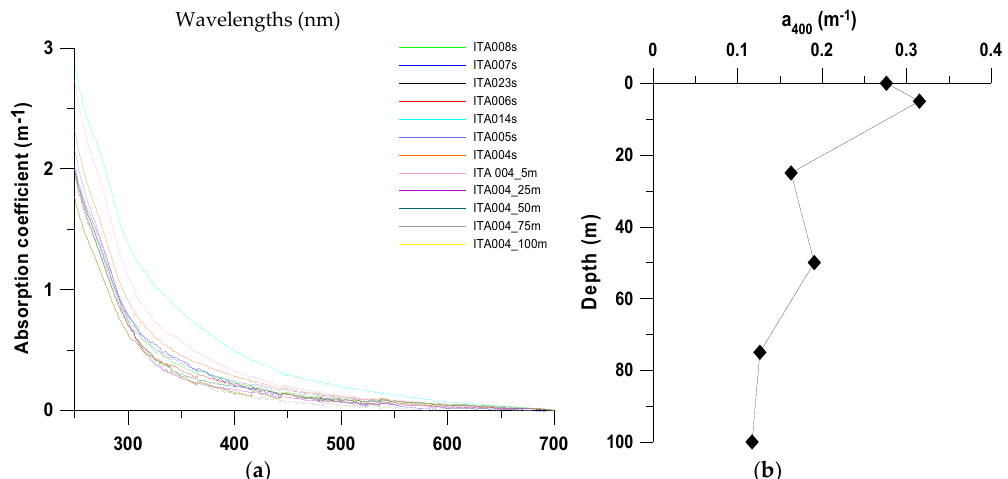
Figure 5. ( a ) Absorption coefficients measured in the study area; ( b ) vertical profile of the absorption coefficient obtained at a 400 nm wavelength at station 4.